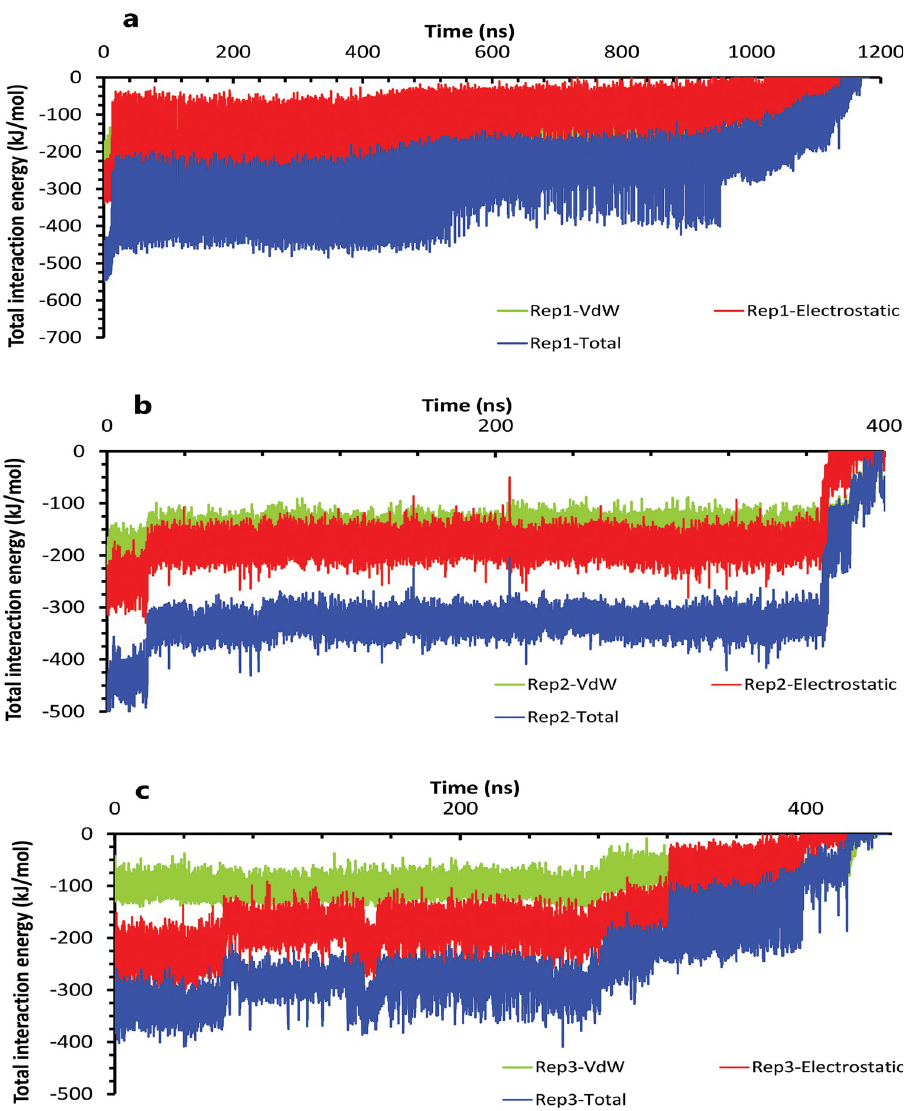
Fig 15. The interaction energies plots of compound 9 in complex with HTLV-1 protease when Asp32 of chain B was protonated in three replicas. A , B , and C , The total VdW and electrostatic interactions energies of protein- inhibitor complexes in rep1, 2, and